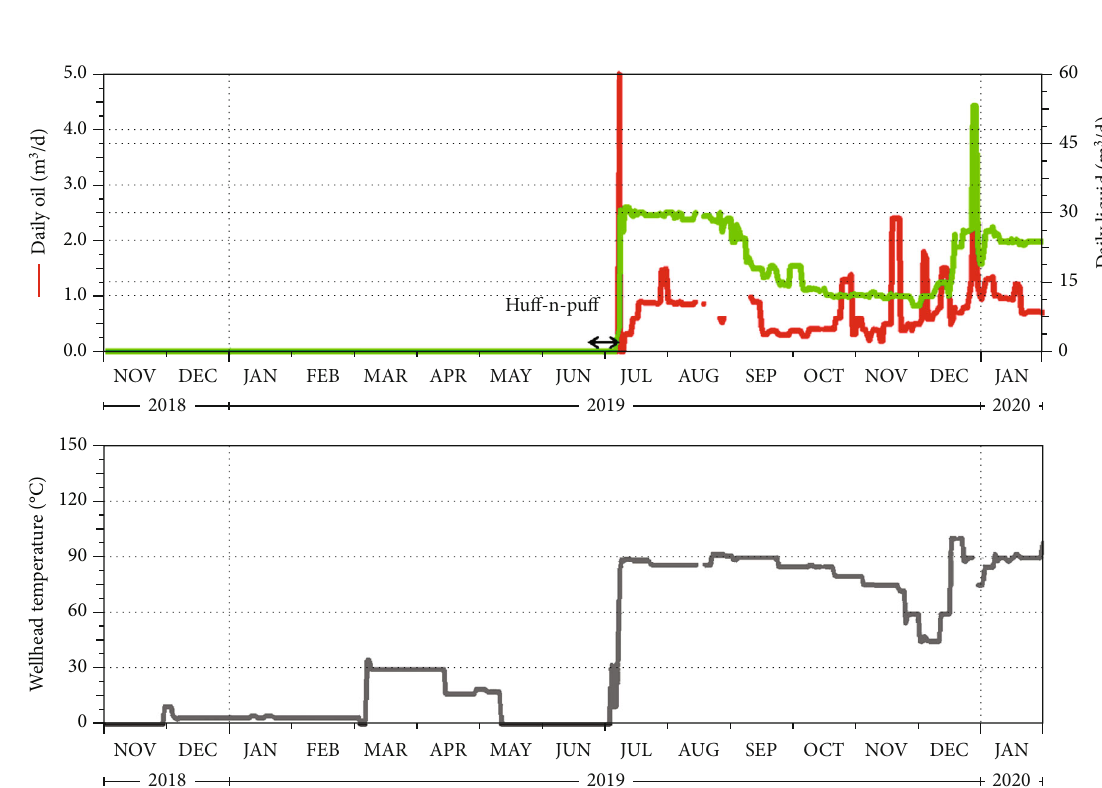
Figure 14: Typical production curves of a type III